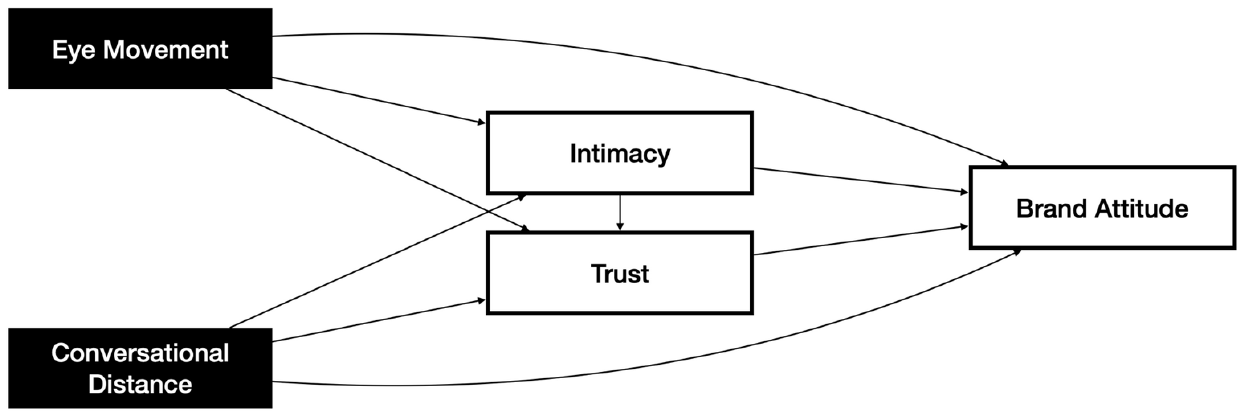
Figure 1. Research